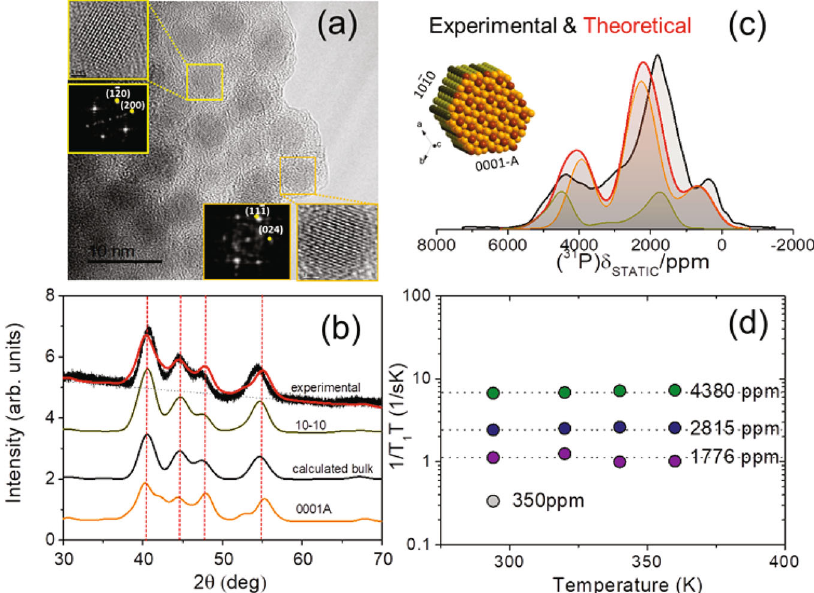
Fig. 5 TEM, XRD and 31 P ssNMR analysis of ultra fi ne Ni 2 P nanoparticles with average particle size of 4.3 nm. a TEM image of the nanoparticles exhibiting the hexagonal symmetry. Insets show magni fi ed images of nanoparticles and the relevant EDPs, which match the calculated EDPs of the ð 10 (cid:1) 10 Þ facet (Fig. 4e). Further details are provided in Supplementary Information Fig 5 . b Experimental (black) and calculated (red) XRD patterns of the nanoparticles. The orange/green/black traces are Gaussian broadened calculated XRD simulations of the (0001-A), ð 10 (cid:1) 10 Þ , and bulk structures. The calculated fi t (red line) is sum of the (0001-A) and ð 10 (cid:1) 10 Þ patterns in ratio 1.75:1. c Experimental (black) and calculated (red) 31 P ssNMR spectrum of the nanoparticles. The orange/green traces are the surface (0001 A)/ ð 10 (cid:1) 10 Þ contributions in the ratio 3.67:1. The inset is sketch of the expected average facet morphology. d 1/ T 1 T vs. temperature for the peaks in the NMR spectrum for the ultra fi ne